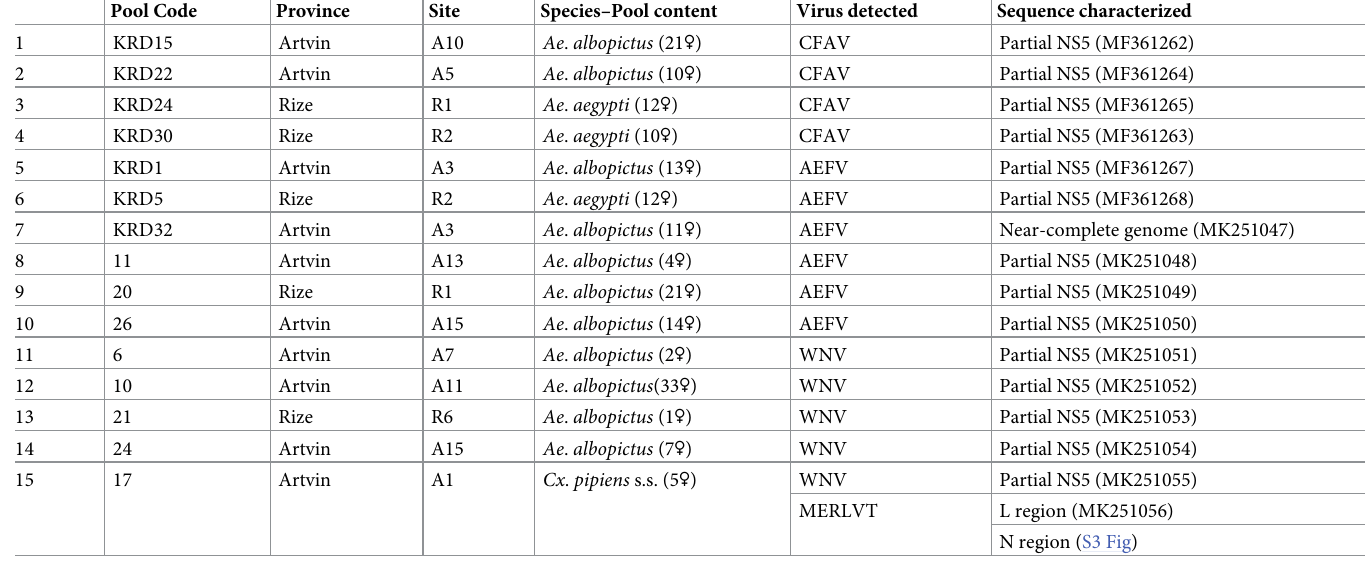
Table 2. The mosquito pools with detectable virus sequences. Pool